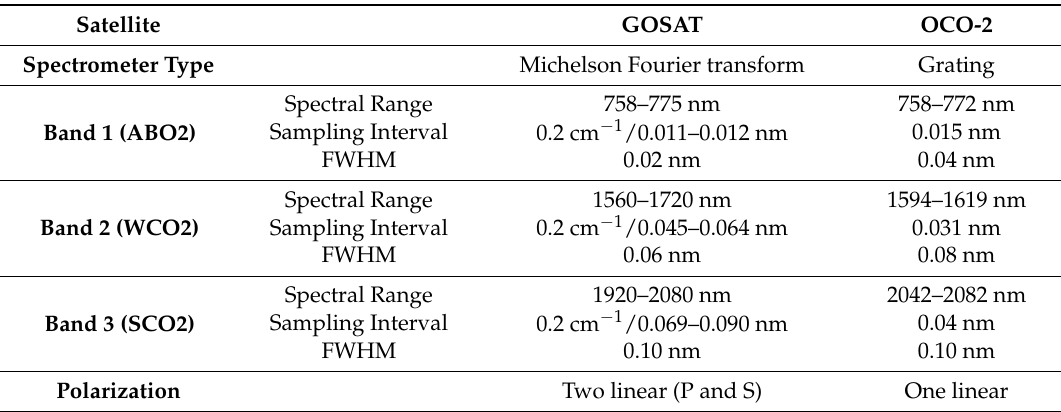
Table 1. The spectral information of GOSAT and